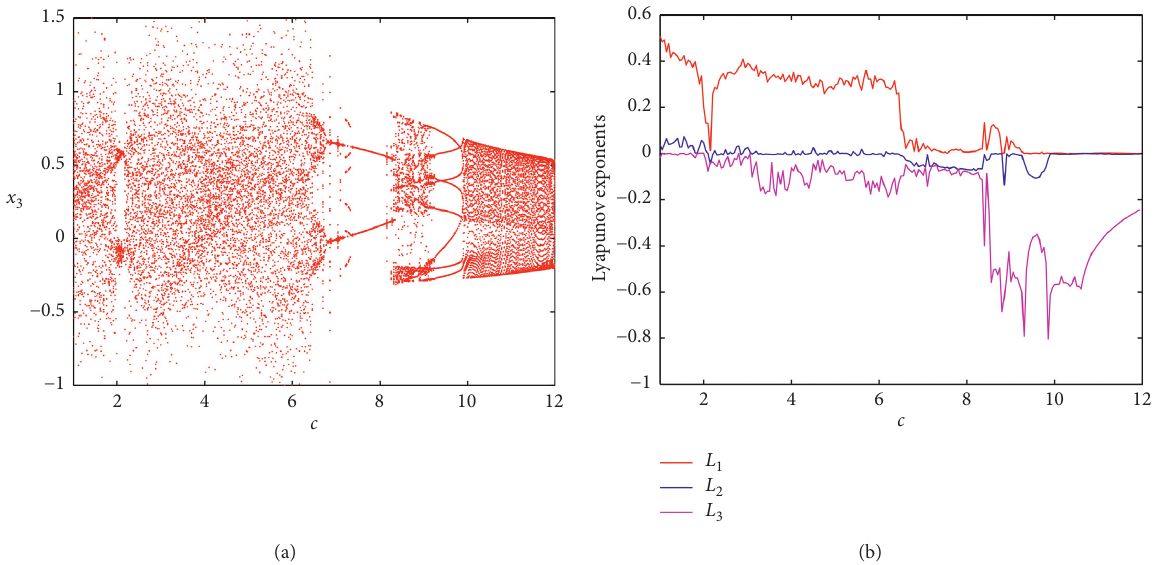
Figure 5: Bifurcation diagram and Lyapunov exponents of system (2) versus c ∈ [ 1 , 12 ] from initial value ( 1 , 1 , 1 , 1 ) , where L are Lyapunov exponents of system (2) and L